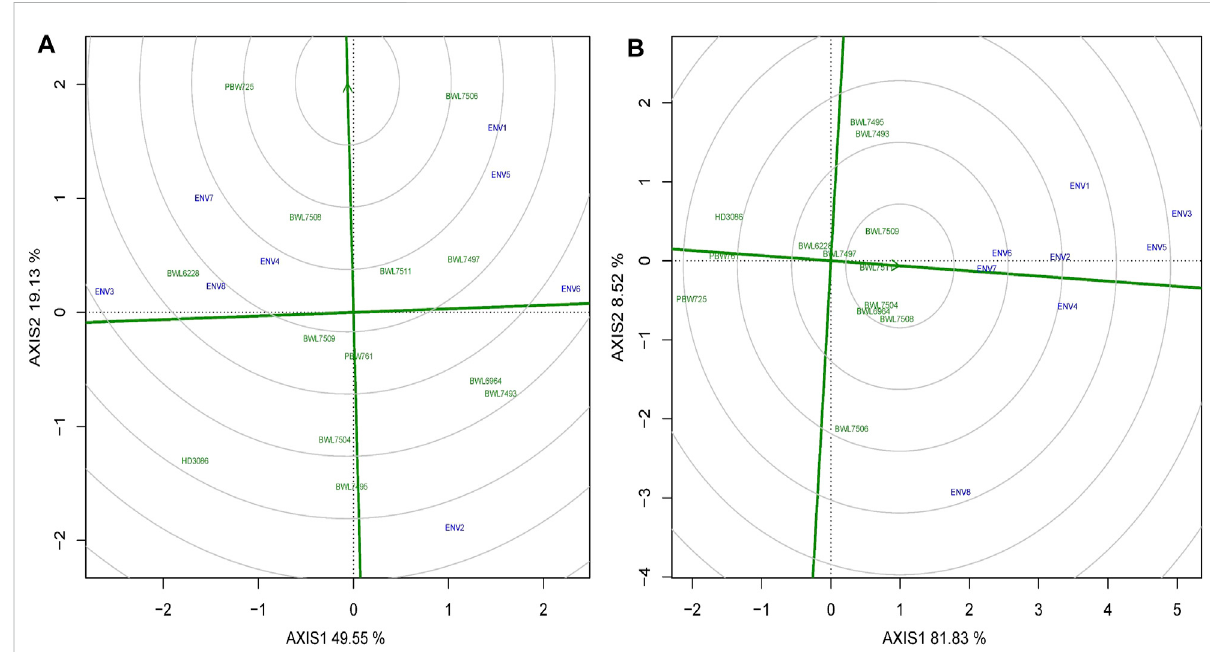
FIGURE 6 The “ ranking genotypes ” model of biplot assess other genotypes against the ideal genotype conferring genotype interaction and GEI for 13 bread wheat genotypes evaluated across four locations (Ludhiana, Ballowal, Patiala, and Bathinda) of Punjab in two consecutive years (2019 – 20, and2020 – 21)for (A) yield(kg/plot),and (B) GPC (%).(ENV1,and ENV5=Ludhiana; ENV2, andENV6=Ballowal; ENV3, andENV7=Patiala; ENV4, and ENV8 = Bathinda).